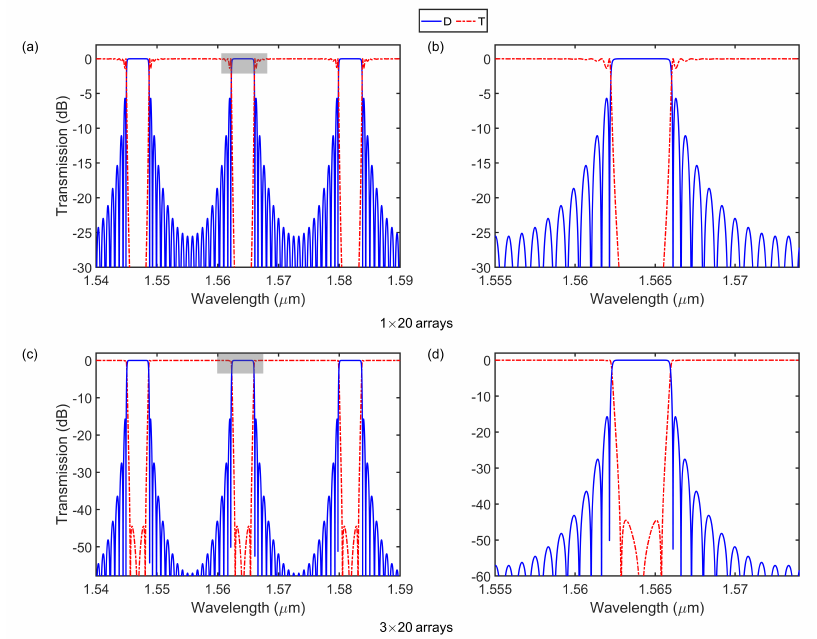
Figure 3. Transmission spectrum at the through (red dashed line) and drop ports (blue solid line) for the ( a , b ) 1 × 20 arrays and the ( c , d ) 3 × 20 arrays. ( b , d ) are the enlarged figures of the shadow area in ( a , c ).